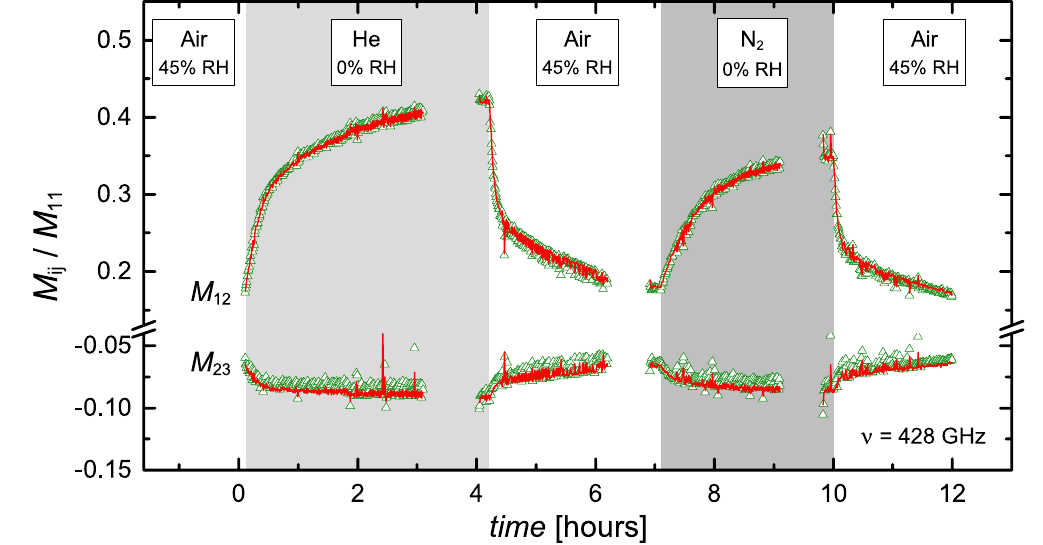
Figure 4. In-situ experimental (green triangles) and modeled (red lines) Mueller matrix data as a function of time for all gas exposure phases. The shaded regions correspond to different types of gas flow at various relative humidities (RH). Data shown here is acquired at a single frequency ν = 428 GHz. Mueller matrix elements not shown here are either similar or identical to the elements depicted and are excluded for brevity. Data is acquired at an angle of incidence Φ a = 45° and at room